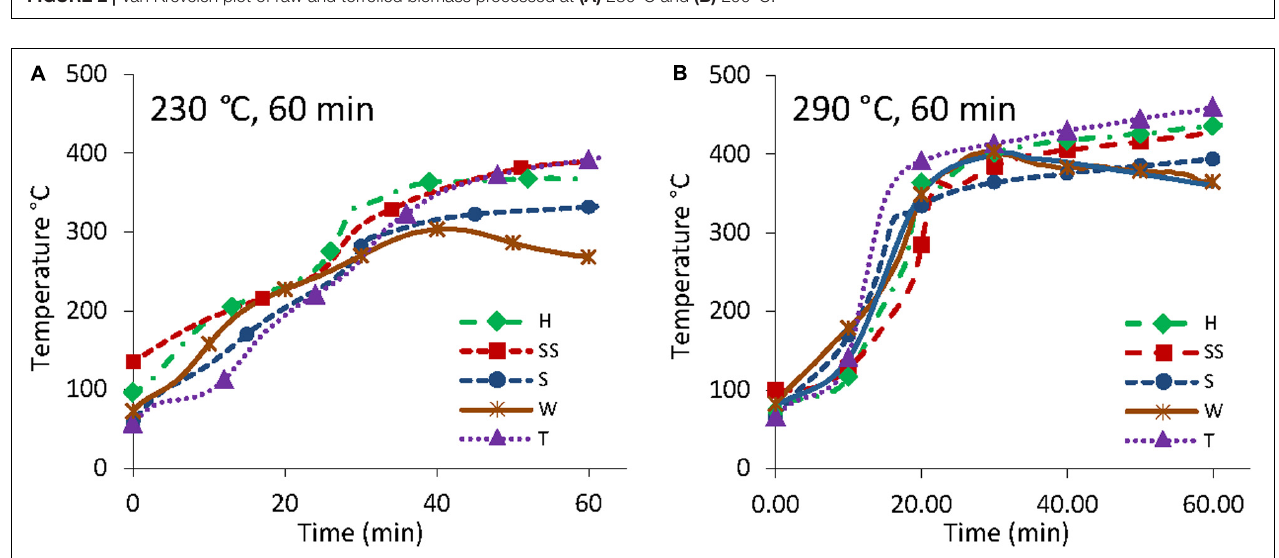
FIGURE 2 | Van Krevelen plot of raw and torrefied biomass processed at (A) 230 ◦ C and (B) 290 ◦ C.